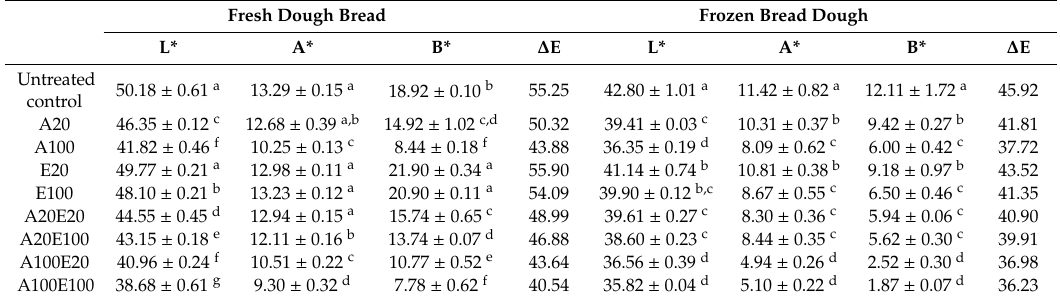
† Means of triplicates. The values with di ff erent letters ( a,b,c,d,e,f,g ) in the same column are significantly di ff